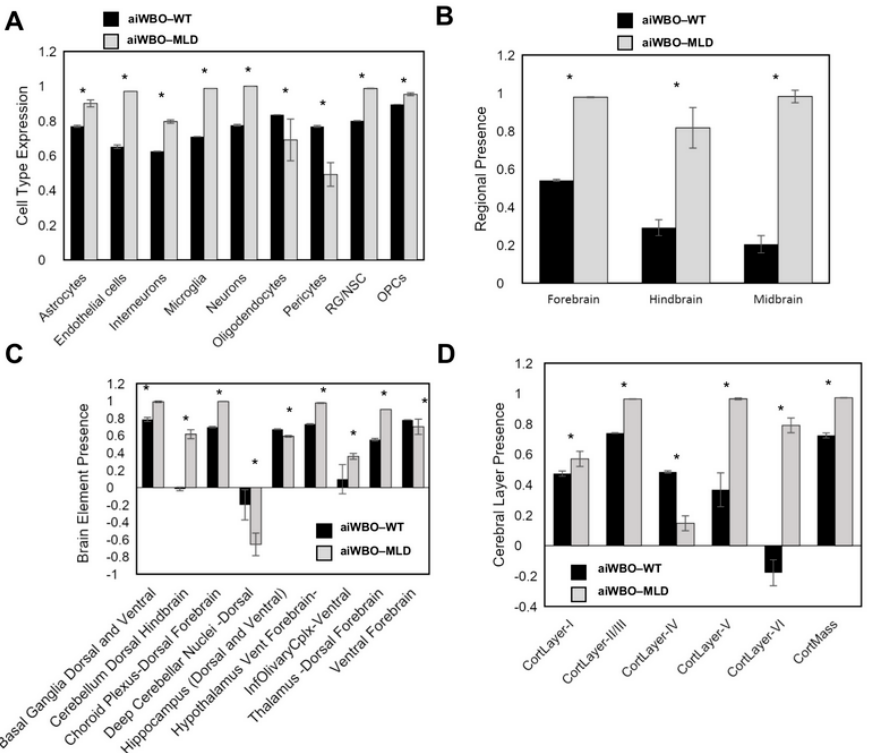
Figure 1. Simulation results of cell types, brain regions and layers in aiWBO–WT vs aiWBO–MLD. ( A ), Comparison of artificially induced whole brain organoid (aiWBO) simulations of wild type (WT) vs Metachromatic Leukodystrophy (MLD) cell types. ( B ), Comparison of brain region concepts in WT vs MLD simulations, ( C ), Comparison of ventral-dorsal concepts in WT vs MLD simulations. ( D ), Comparison of cerebral cortical layers in WT vs MLD simulations. The vertical y-axes represent the semiquantitative levels of concepts that are estimated by DeepNEU relative to an arbitrary base line where 0 = base line, 1 = maximum expression or presence and − 1 = minimal expression level or presence. The horizontal x-axes represent the individual aiWBO concepts being simulated. Data represent means of three experiments ± 95% confidence interval. All p -values from Mann-Whitney U test. * p < 0.01.